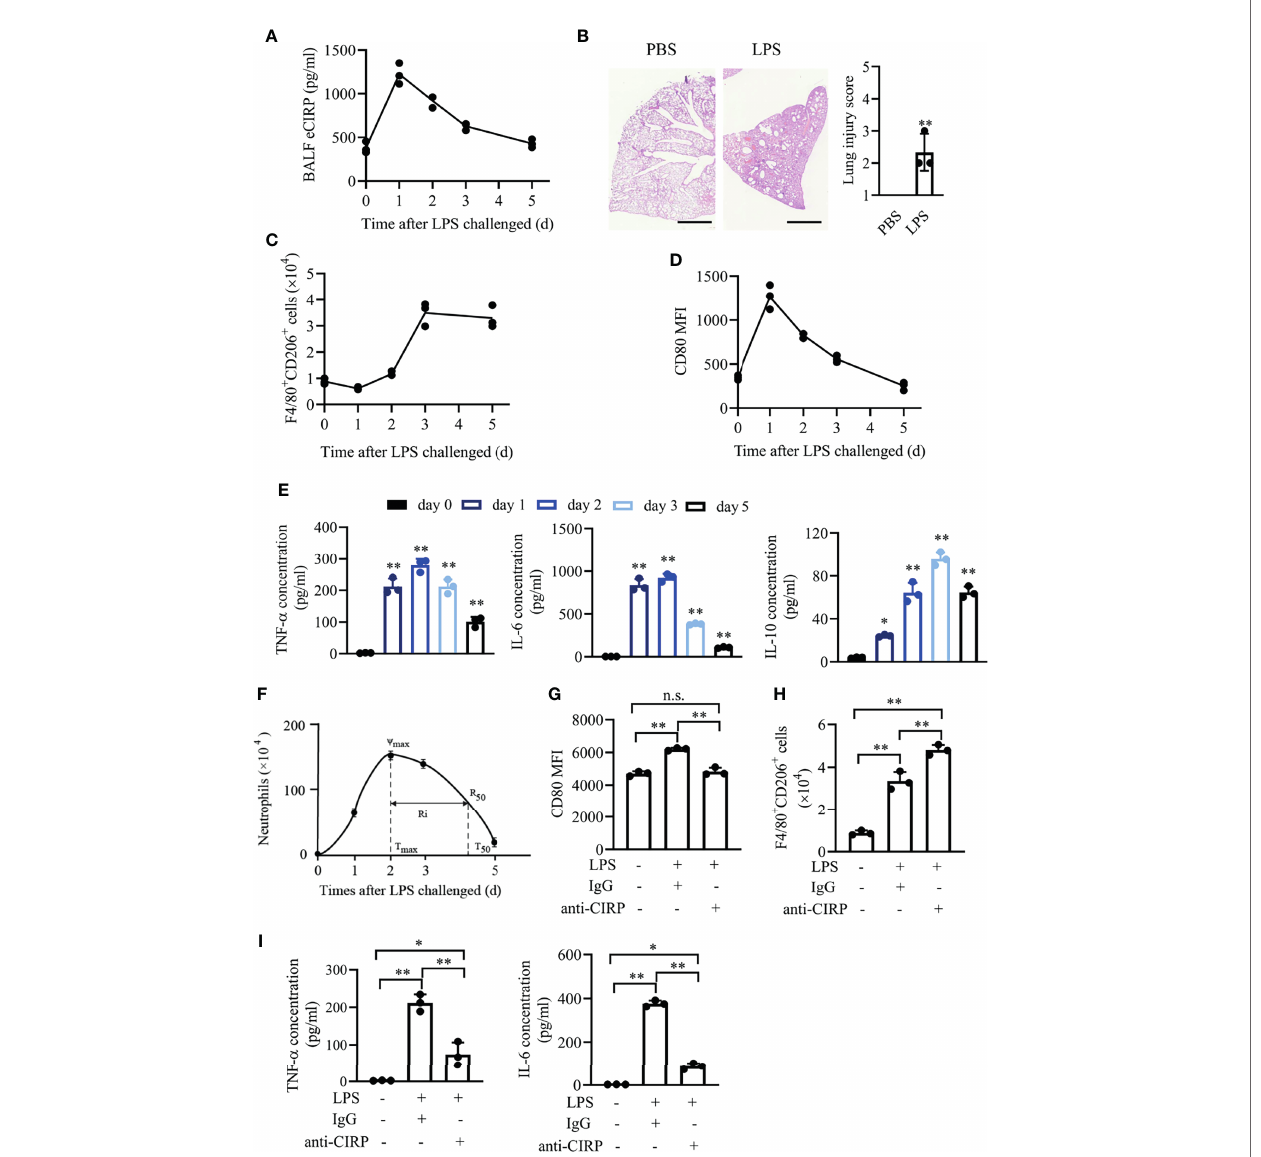
FIGURE 1 | eCIRP is temporally activated in acute lung injury. WT mice (n = 8 for each time point) were treated with 3 mg/kg LPS (i.t.) at the indicated times (days 0, 1, 2, 3, and 5). (A) The concentrations of BALF eCIRP were measured by ELISA at the indicated time after LPS administration i.t. (B) Lung tissue samples from mice with LPS or PBS administration for 24 h were dissected and subjected to H&E staining. Left panel: representative lung tissue images. Right panel: histopathological mean lung injury scores from each group. Scale bar: 1,000 µm. Measurements were performed in triplicate for data analysis. ** P < 0.01 vs. PBS group. Macrophages (F4/80 + Ly-6G - ) in BALF from WT mice were collected at 0, 1, 2, 3, and 5 days after i.t. LPS (3 mg/kg) challenge, and the number of CD206 + (C) macrophages and the MFIs of CD80 (D) in BALF macrophages were measured by FACS. (E) The concentrations of secreted TNF- a , IL-6, and IL-10 in BALF at the indicated time were measured. (F) The time course of neutrophil (Ly6G + F4/80 - ) numbers in BALF and resolution indices was calculated by fl ow cytometry. WT mice were administered LPS (3 mg/kg, i.t.) and then were treated with IgG or anti-CIRP antibody (1 mg/kg/day) via caudal vein for 3 days. Control mice were administered PBS. The macrophages ’ MFIs of CD80 (G) , the number of CD206 + macrophages (H) , and cytokine expression (I) in BALF at day 3 after LPS treatment were measured (n = 3). Data are representative of at least two independent experiments. Results were expressed as mean ± SD. n.s., not statistically signi fi cant., * P < 0.05, ** P < 0.01 compared to 0 h group. Statistics: unpaired two-tailed Student ’ s t-test (B) , one-way ANOVA with Tukey ’ s post-hoc test for multiple comparisons (E, G – I) . eCIRP, extracellular cold-inducible RNA-binding protein; WT, wild type; BALF, bronchoalveolar lavage fl uid; ELISA, enzyme linked immunosorbent assay; LPS, lipopolysaccharide; FACS, fl uorescence activated cell